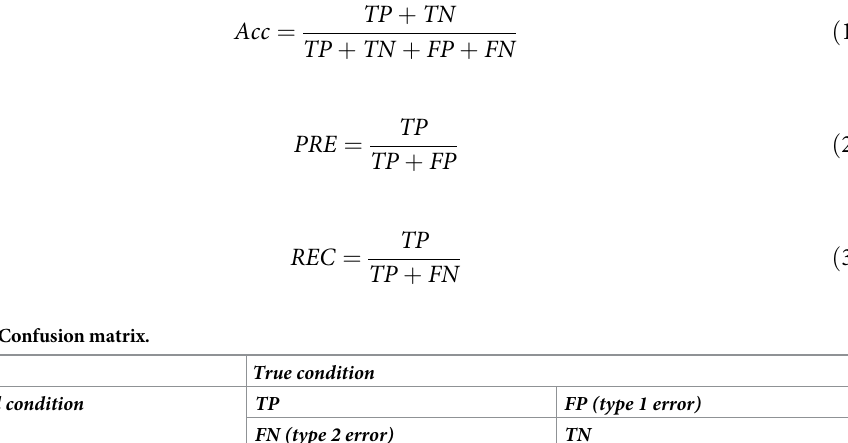
Confusion matrix (CM): CM, also known as the error matrix, is a unique table representa-